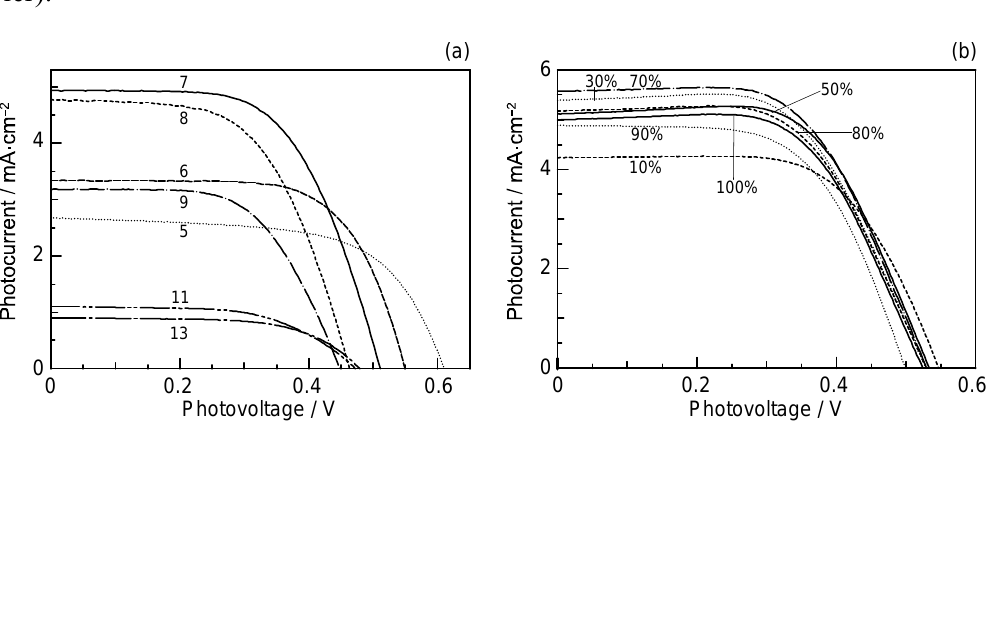
Figure 5. (a) Conjugation-length ( n ) dependence of the I–V curves in solar cells using the RA and CA sensitizers, and (b) the concentration dependence of the I–V curve in CA7- sensitized solar cells (reprinted from [10], Copyright (2005), with permission from